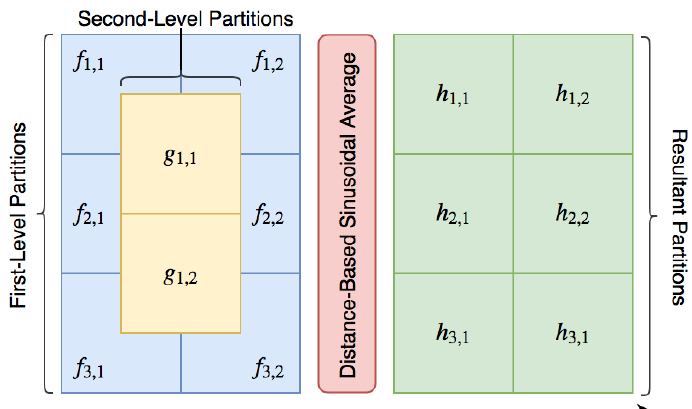
Figure 2. Graphical concept of overlapping partitions where l is the length of each partition. f and g denote the partition levels. h is the reconstructed partition from the application Equation (5) to f and g partitions.